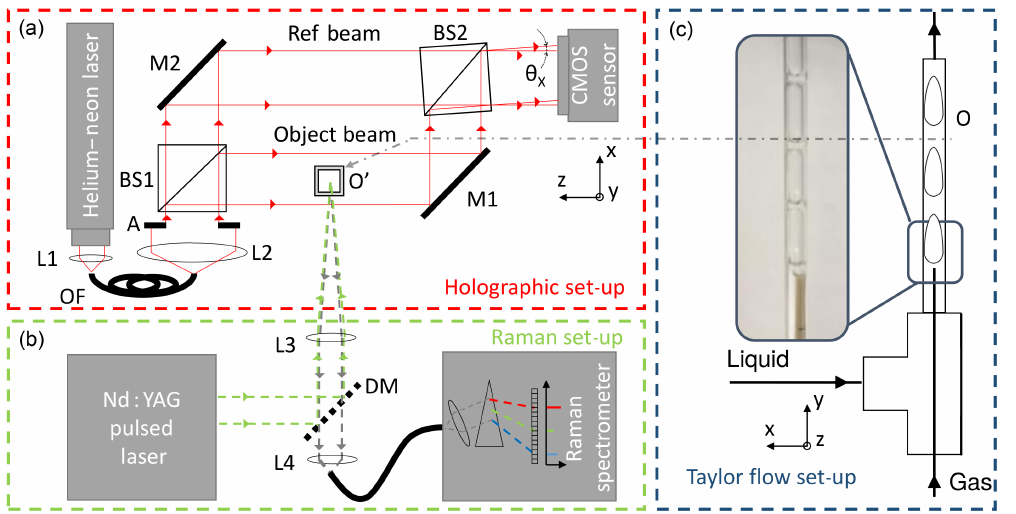
Figure 1. A combined Mach–Zehnder holography and confocal Raman-spectroscopy sensor system set-up. (a) The digital Mach–Zehnder holography subsystem, (b) the confocal Raman-spectroscopy subsystem (c) and the Taylor flow set-up. O is the side view of the microchannel and O (cid:48) is the top view viz. the cross section of the